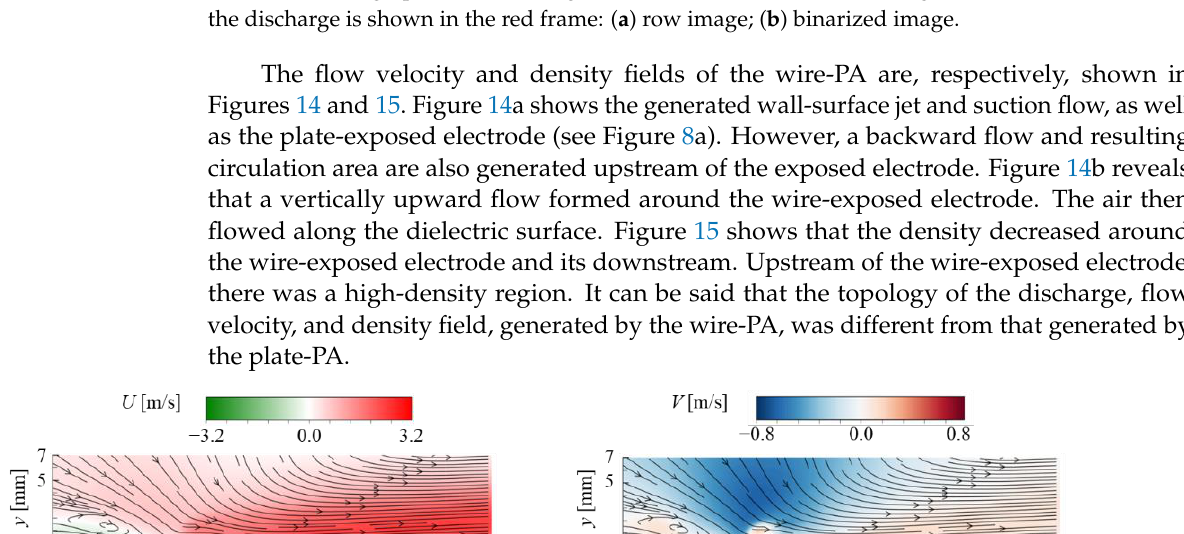
Figure 13. Photograph of the discharge emission of the wire-PA. An enlarged view of the area around the discharge is shown in the red frame: ( a ) row image; ( b ) binarized image.